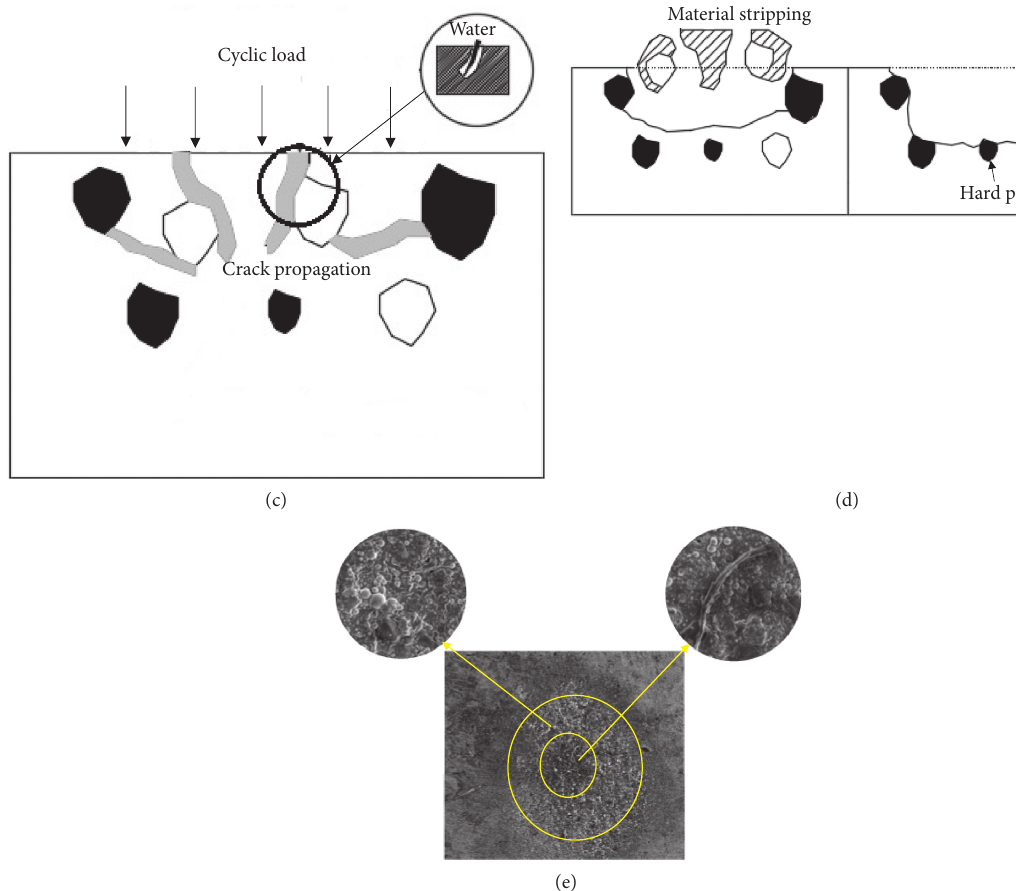
Figure 8: Grade-A ship steel jet erosion and peeling model. (a) Cyclic stress. (b) Microcrack initiation. (c) Water wedge. (d) Material stripping. (e) After